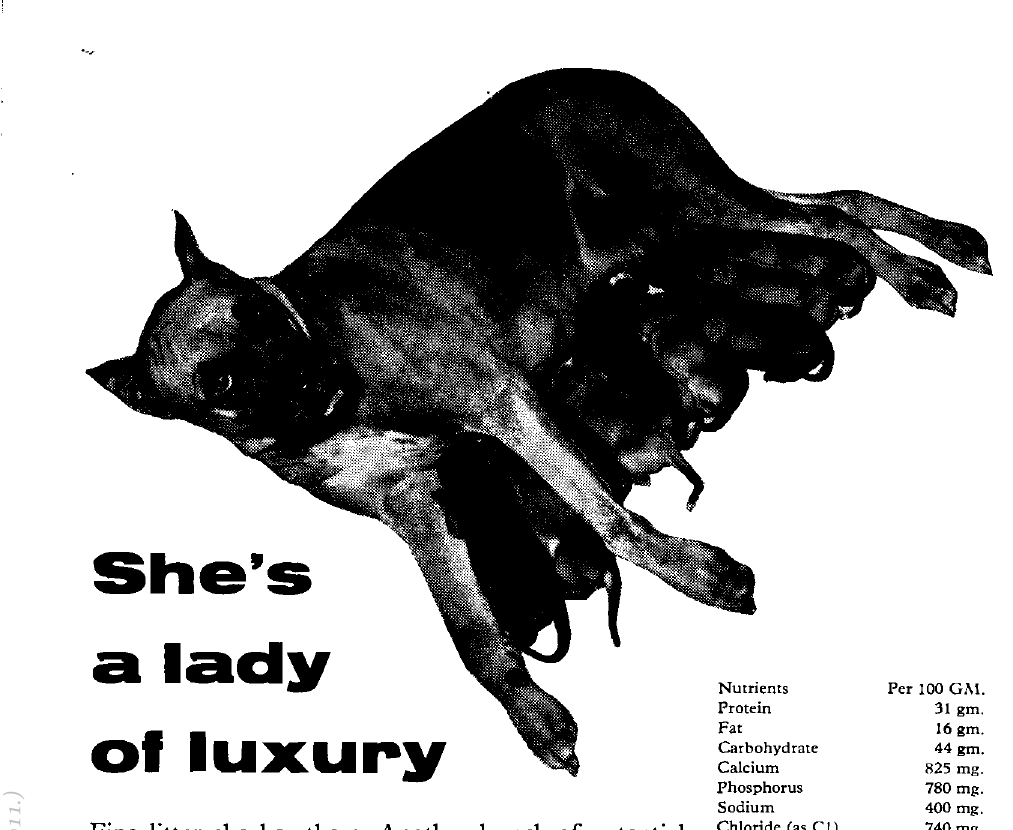
For the smaller animals during and after parturition; after surgery (particularly of the gastro-intestinal tract); and for those off their food as in illstemper or hard pad-Complan feed,